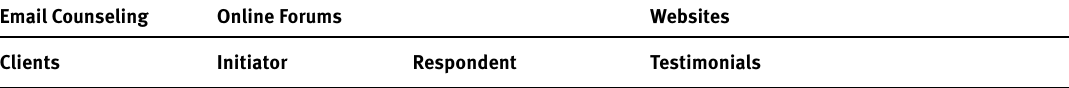
Table 2: Narrative functions according to sub-corpora, presented in order of likely sequence of